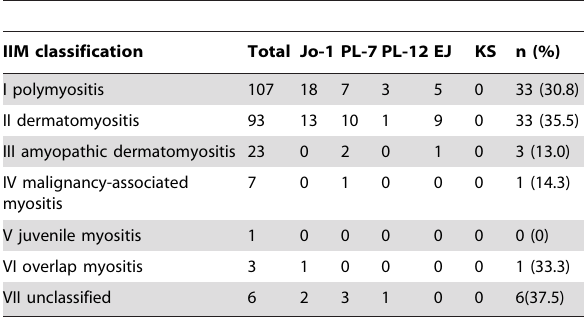
Table 3 The frequency of each anti-ARS antibody in subsets of